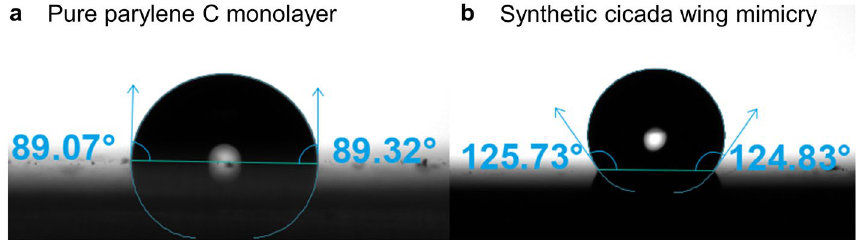
Figure 5. Water contact angle measurement on ( a ) pure parylene C monolayer, and ( b ) synthetic cicada wing